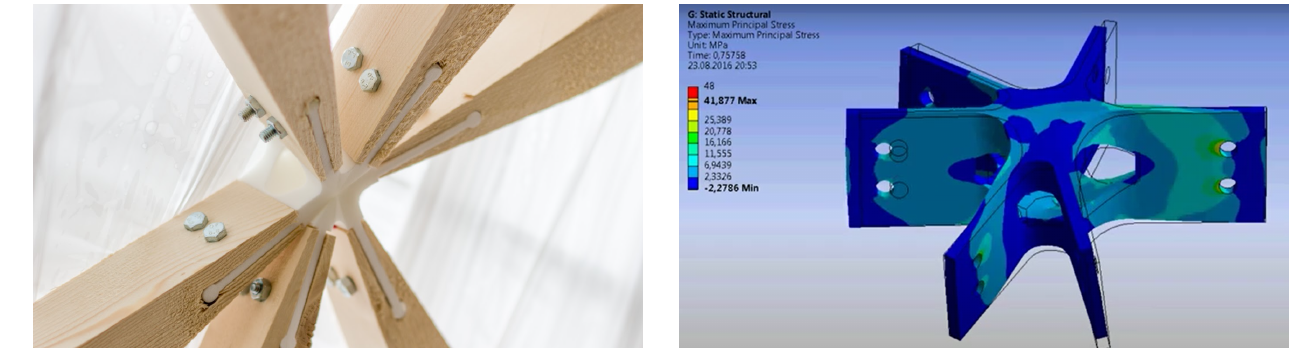
Figure 1. The node at the Printshell project and the ANSYS analysis at the